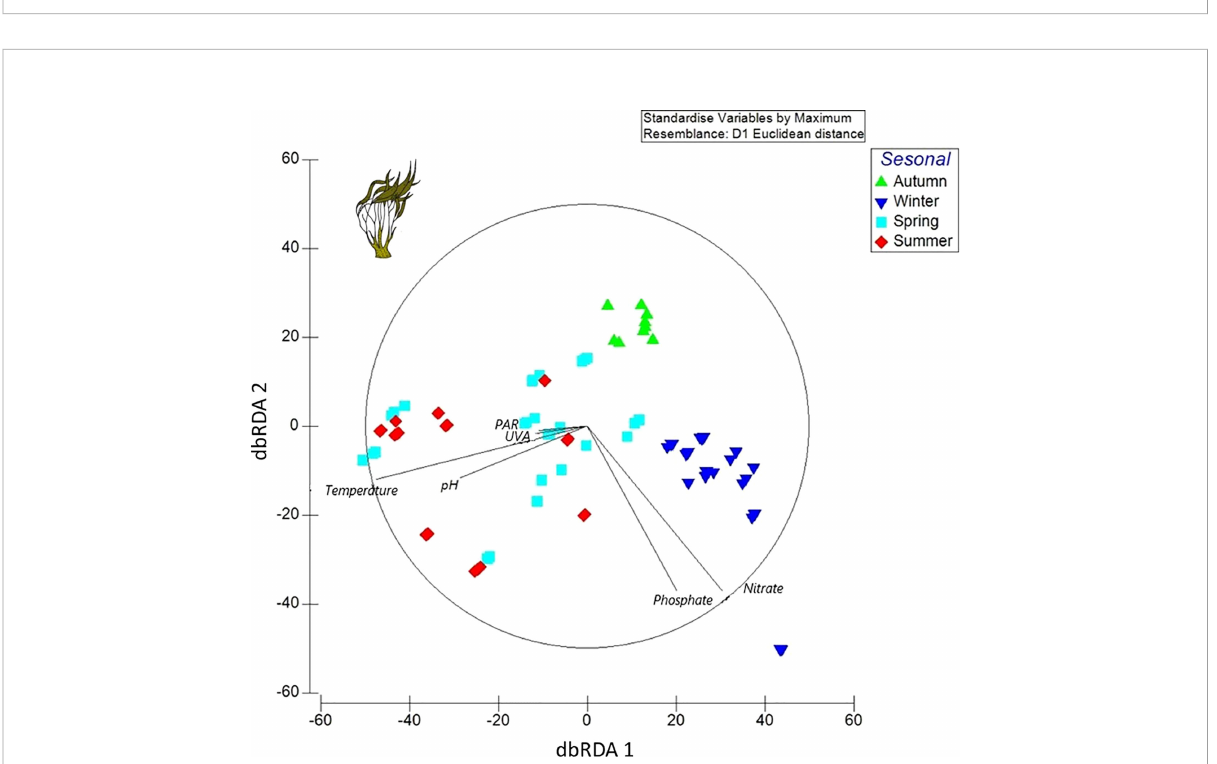
FIGURE 3 Redundancy analysis (dbRDA diagram) of Lessonia spicata throughout the seasons considering ecophysiological variables related to abiotic parameters: PAR (photosynthetically active radiation), UVA (ultraviolet-A), temperature, pH, and NO 3 − (nitrate); with respect to seasons: autumn (green triangle), winter (blue invert triangle), spring (light blue square), and summer (red